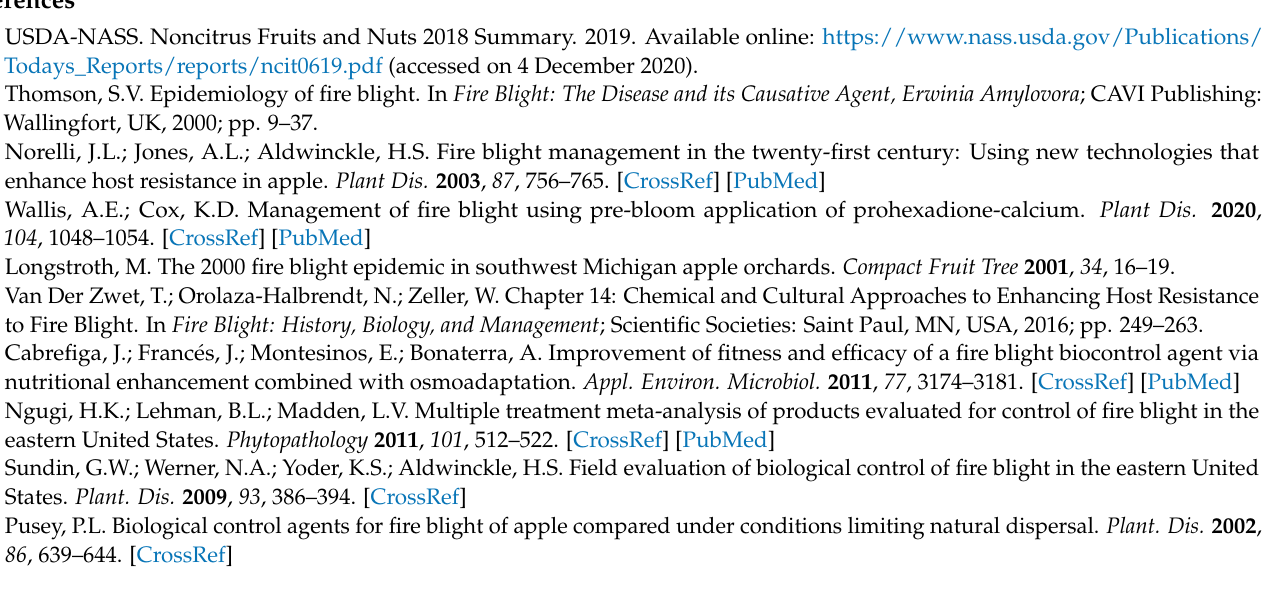
Table S1: Primers used for E. amylovora characterization. Table S2: Significant pairwise comparisons between species with 10 or more